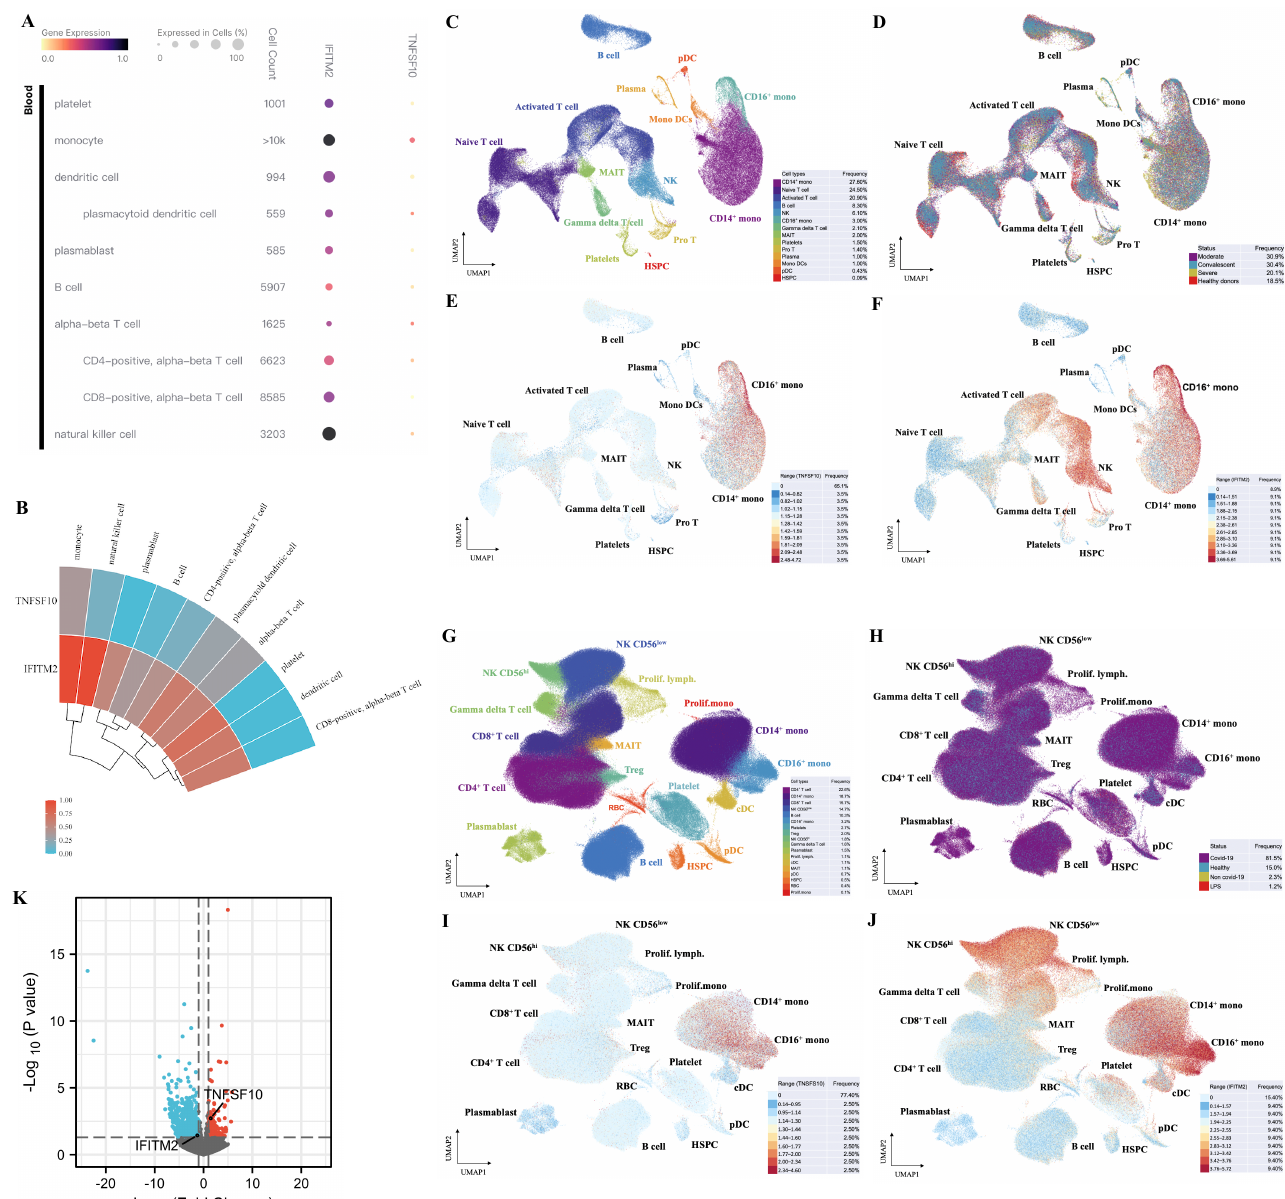
(Figure 10F). We also used the single-cell RNA-seq data published by Stephenson et al. (2021) [26] to verify the above conclusions. PBMC samples from 41 controls and 102 COVID- 19 patients were obtained. 781,123 single cells were classified into 18 clusters (Figure 10G,H). Figure 10I,J described similar conclusions: compared with other immune cells, TNFSF10 was highly expressed in CD14+ and CD16+ monocytes. IFITM2 was highly expressed in CD14+, CD16+ monocytes and NK cells.